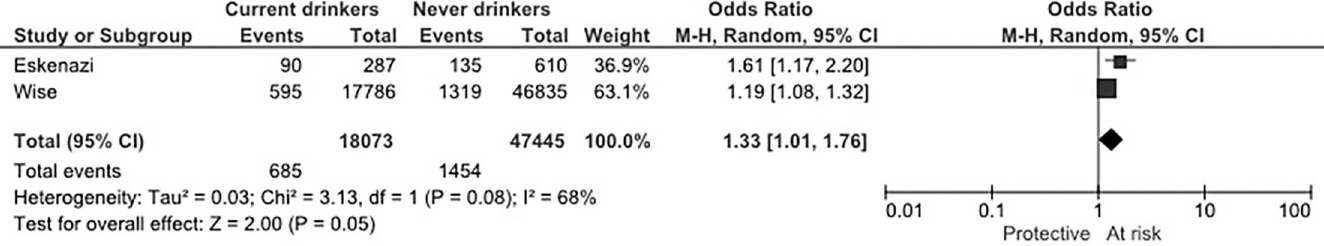
PLOS ONE | https://doi.org/10.1371/journal.pone.0188355 November27,